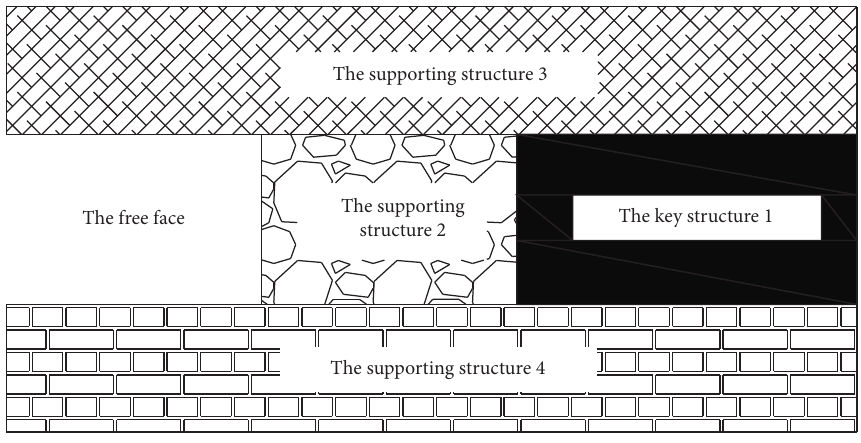
Figure 1: The key structure model of coal and gas outburst